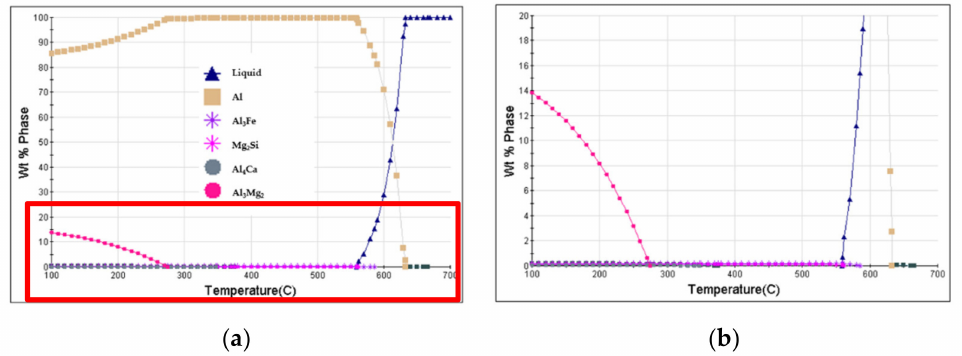
Figure 1. ( a ) Calculated equilibrium phase fraction as a function of temperature; ( b ) close inspection of y-axis (weight percent of equilibrium phase fraction as a function of